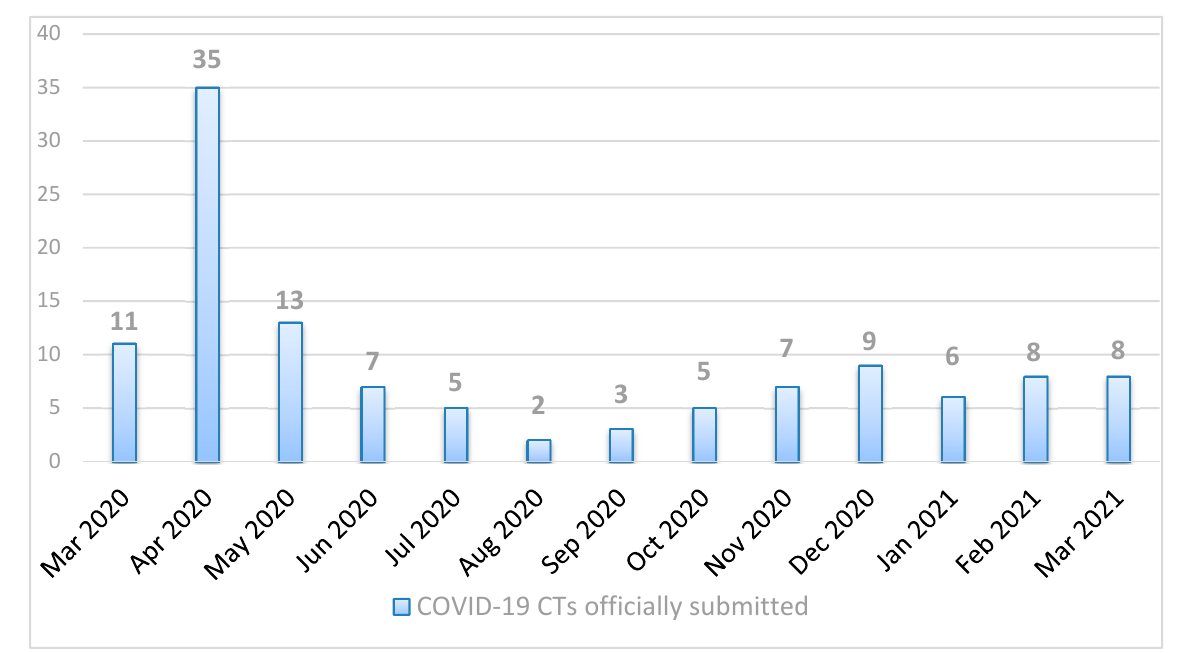
Figure 1. COVID-19 CTs officially submitted with a unique EudraCT number to the CTO on a monthly basis from March